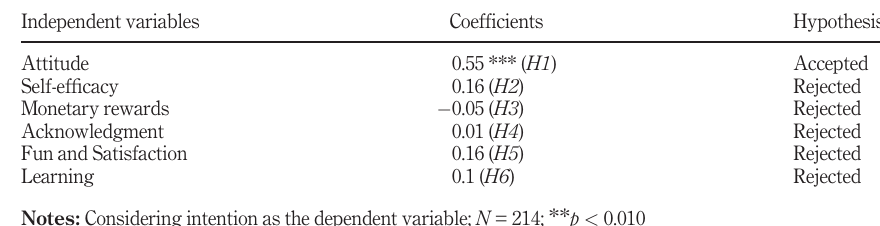
Table IV. Multiple